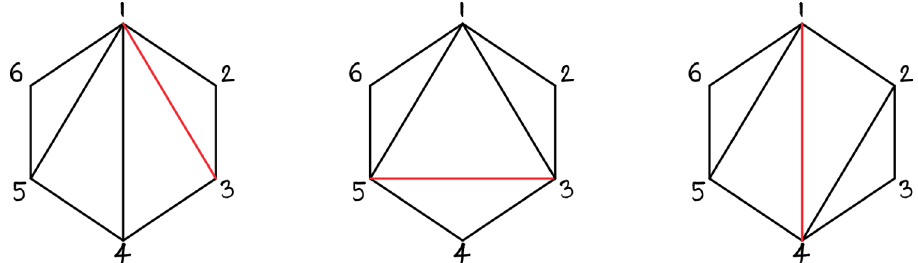
Figure 2 . Mostly Black triangulations with (13) red and (14),(15) black on the left, (35) red and (13),(15) black in the center and (14) red and (24),(15) black on the